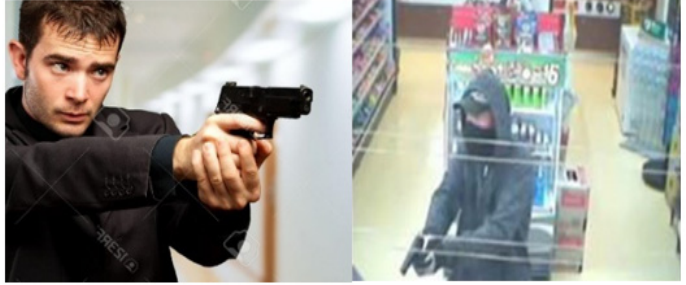
Figure 1. Data samples for pistol category.